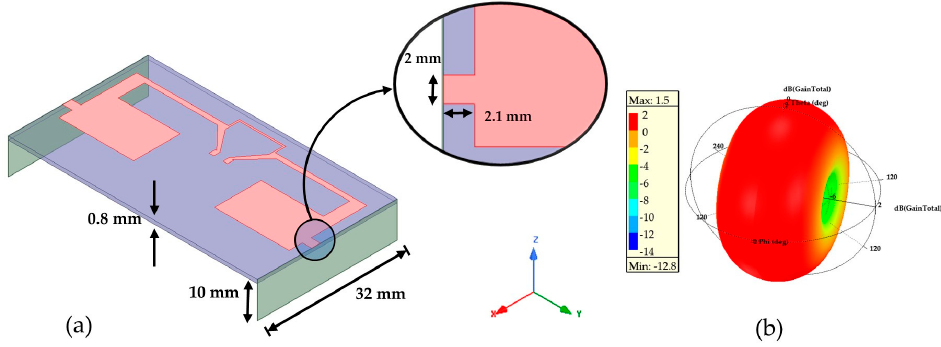
Figure 5. ( a ) Geometry of the 3D configuration antenna with the connected metallic arms; ( b ) Simulated 3D gain polar plot at 868 MHz.